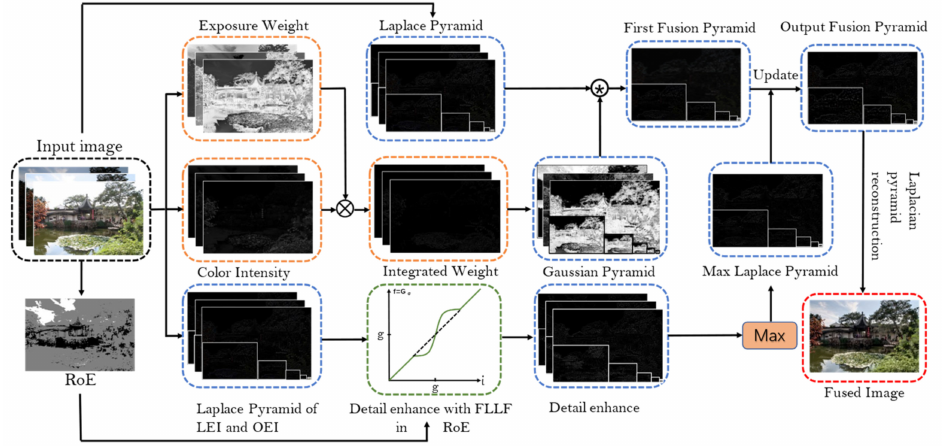
Figure 1. Frame diagram of fusion.